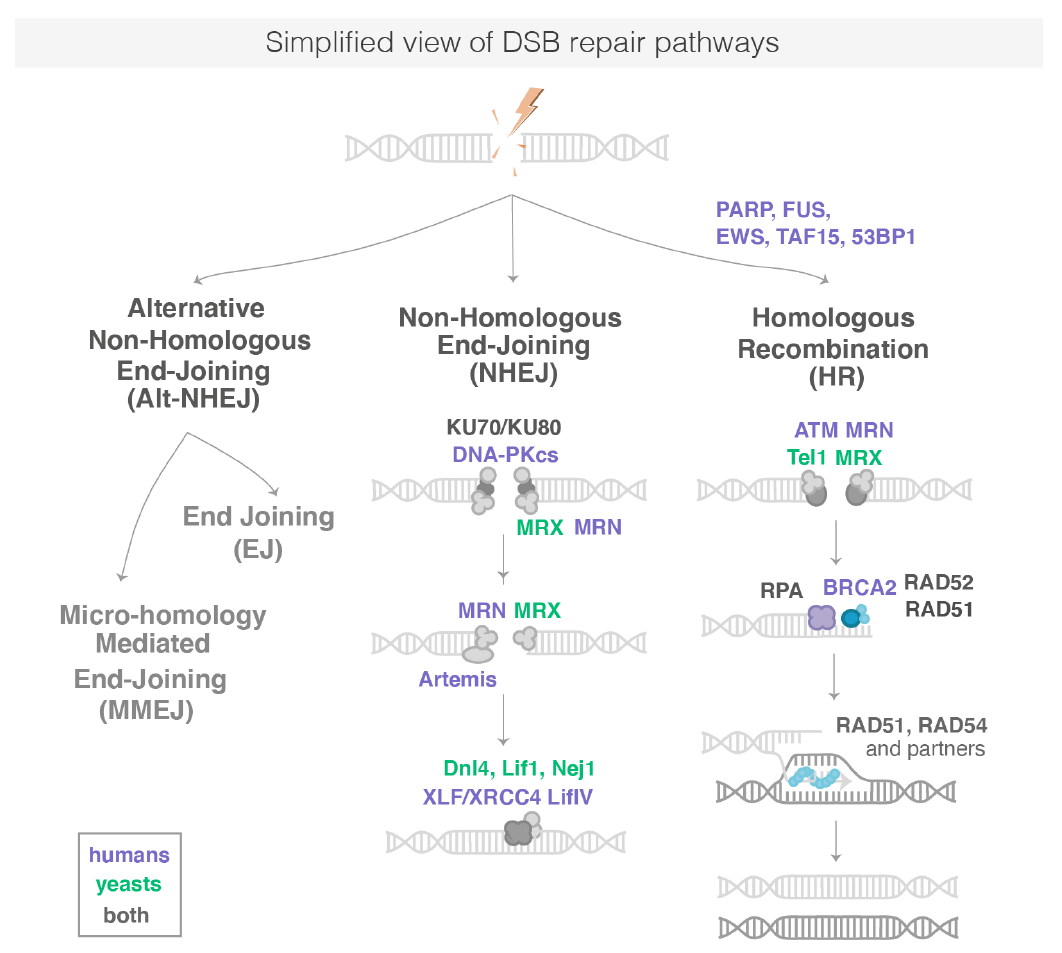
Figure 1. Simplified representation of DSB repair pathways. DSB are repaired by HR, c-NHJE or Alt-NHEJ. Proteins in bold are known to form repair foci in cells. The sub-pathways of the Alt-NHEJ Figure 1. Proposed algorithm flow diagram are not represented here. NB: Proteins common between Sc. Yeast and human are written in grey with the nomenclature used for human